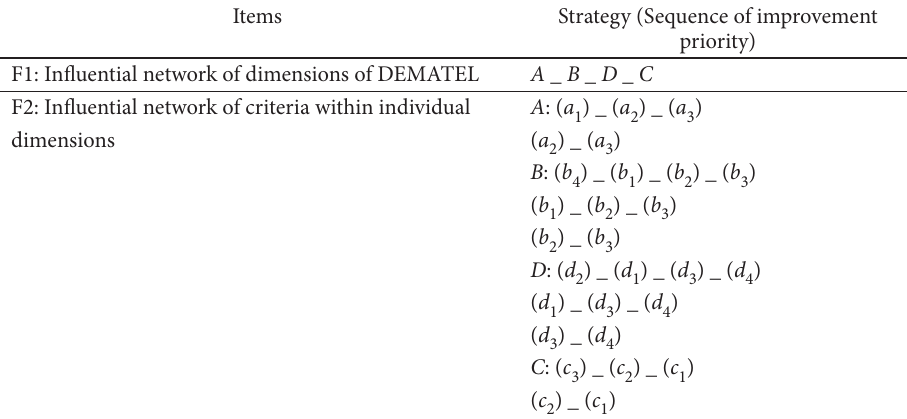
Table 10. The financial center modernization implementation improvement plan Items Strategy (Sequence of improvement